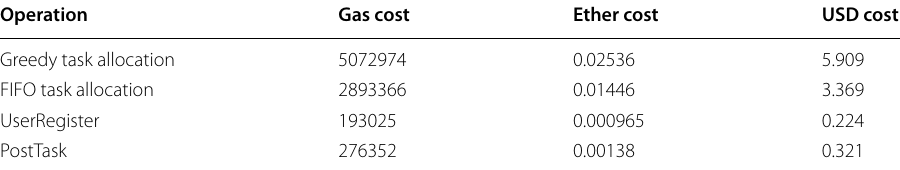
Table 2 Gas consumption of main function